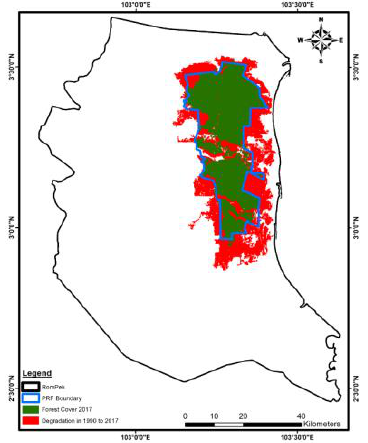
Figure 5. Peat swamp forest spatial